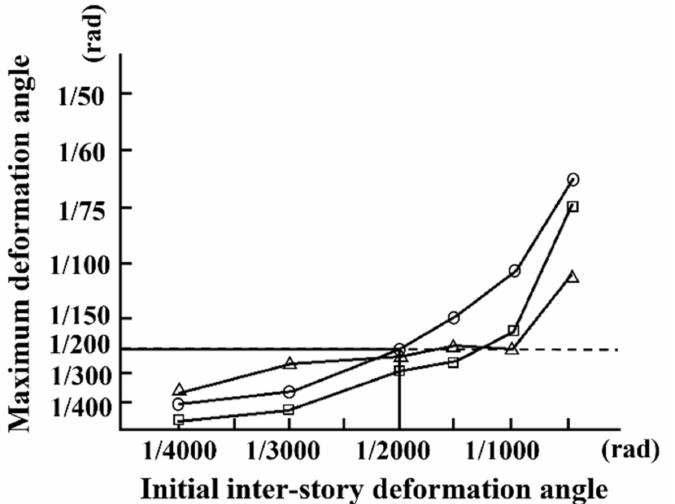
Figure 4. Relation of initial stiffness and maximum inter-story deformation